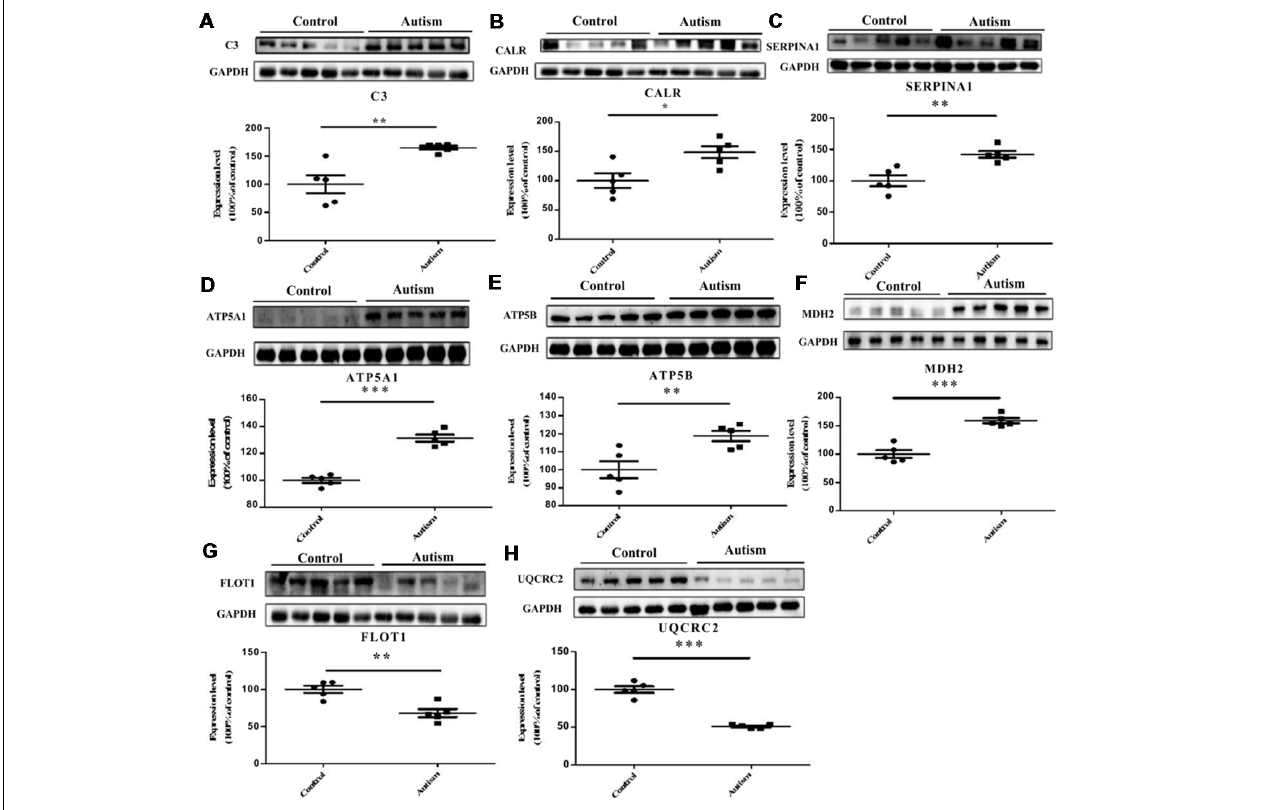
FIGURE 6 | Validation of differentially expressed proteins in PBMCs of children with autism by Western blot analysis. (A) Complement C3 (C3). (B) Calreticulin (CALR). (C) Alpha-1-antitrypsin (SERPINA1). (D) ATP synthase subunit alpha, mitochondrial (ATP5A1). (E) ATP synthase subunit beta, mitochondrial (ATP5B). (F) Malate dehydrogenase, mitochondrial (MDH2). (G) Flotillin-1 (FLOT1). (H) Cytochrome b-c1 complex subunit 2, mitochondrial (UQCRC2). The level of protein expression is normalized with the mean of the controls ( n = 5), with each bar representing the standard deviation (SD; P < 0.05). The upper images of Western blot analysis correspond to the lower histograms of semiquantification. ∗ P < 0.05, ∗∗ P < 0.01, ∗∗∗ P <